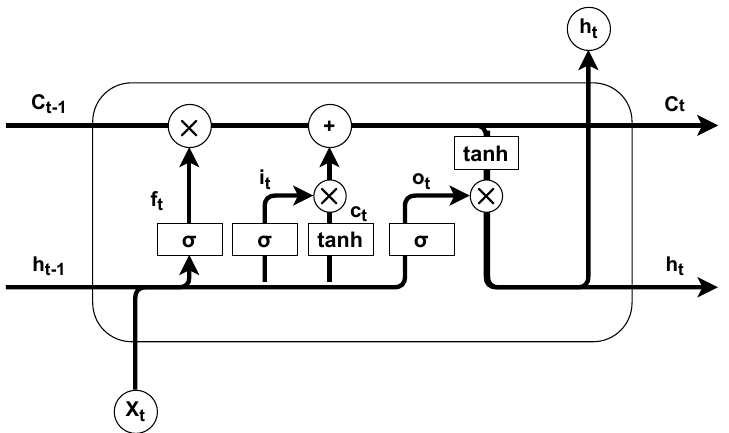
Figure 5. Architecture of a LSTM (Long Short-Term Memory)